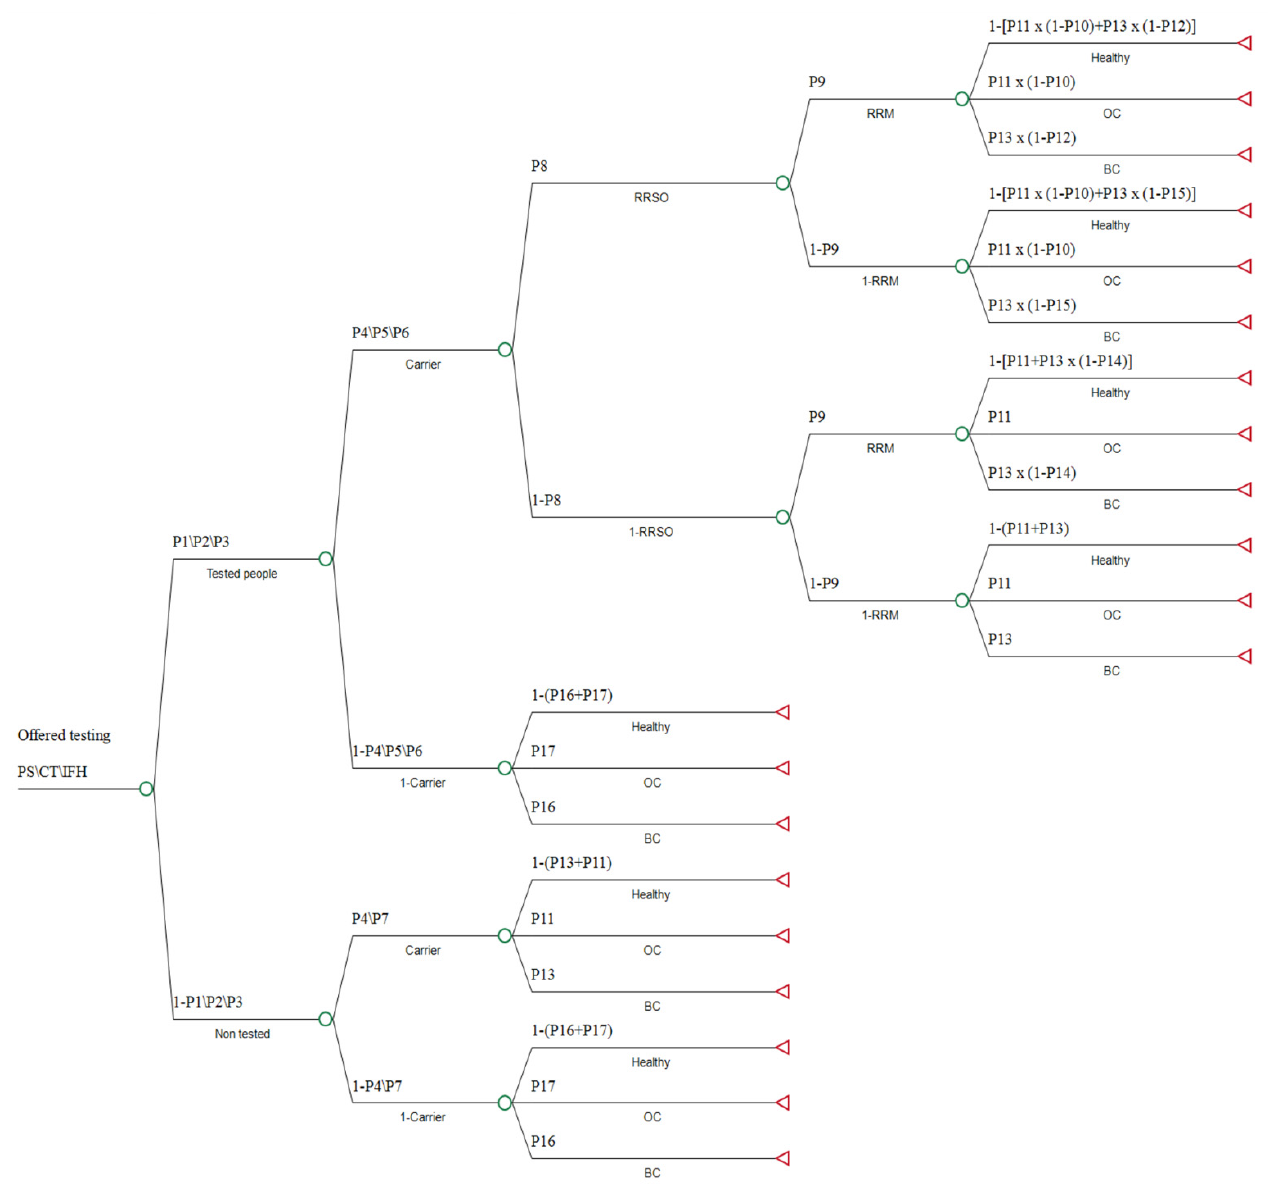
Figure 1. Decision tree. The decision tree has similar branches for all three strategies, and therefore shown only once. The numerical value of each probability (P) is shown in Table 1. In branches where different probabilities were used for each strategy, they are indicated in the following order PS \ CT \ IFH (PS—Population screening, CT—Cascade testing, IFH—International Family History). Healthy—unaffected with cancer. BC—Breast Cancer. OC—Ovarian Cancer. RRM—risk-reduction